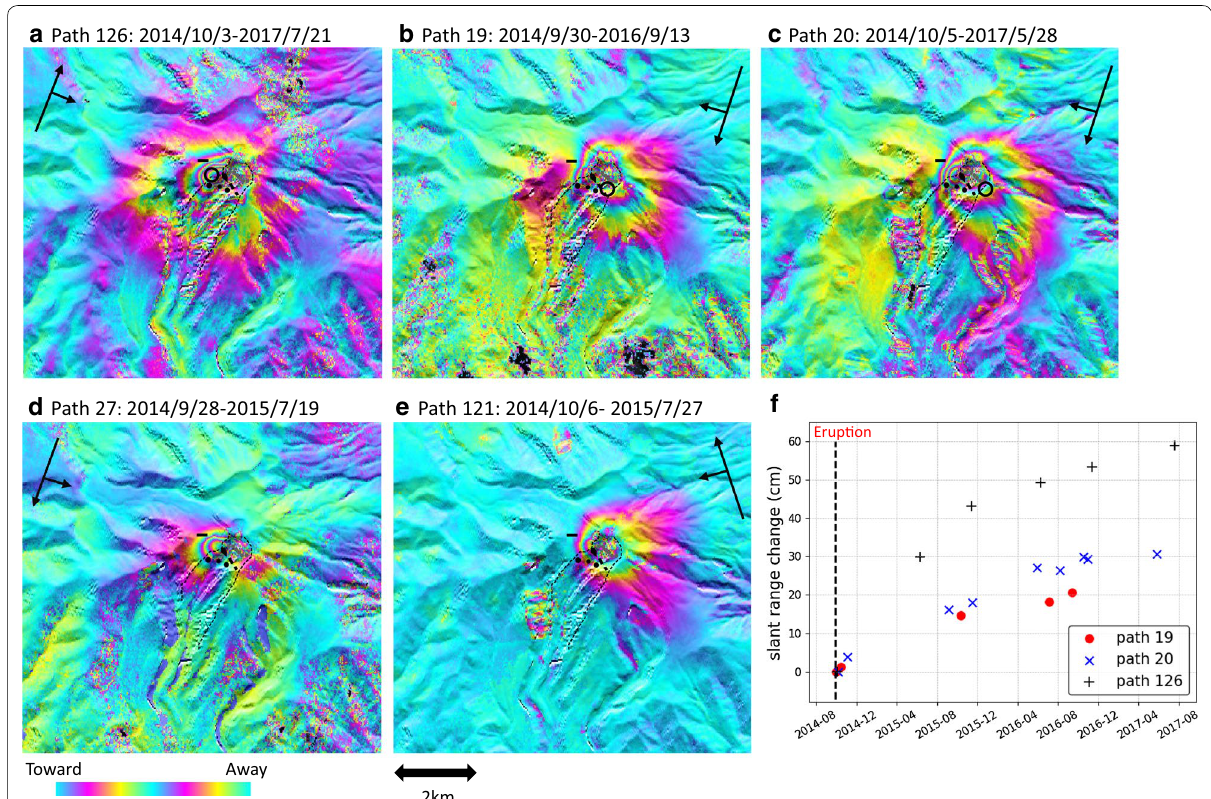
Fig. 3 Results of SAR interferometry for the area in Fig. 1 inset. a – e are interferograms depicting the stacked dLOS. The path and period for the stacking are shown at the top of each interferogram. f Time series of the dLOS at fixed pixels as indicated with black circles in ( a – c ). Positive dLOS values correspond to increases in the slant range between the satellite antenna and the ground target. Arrows represent the flight and viewing direction of the ALOS-2. Black dots are eruptive vents for the 2014